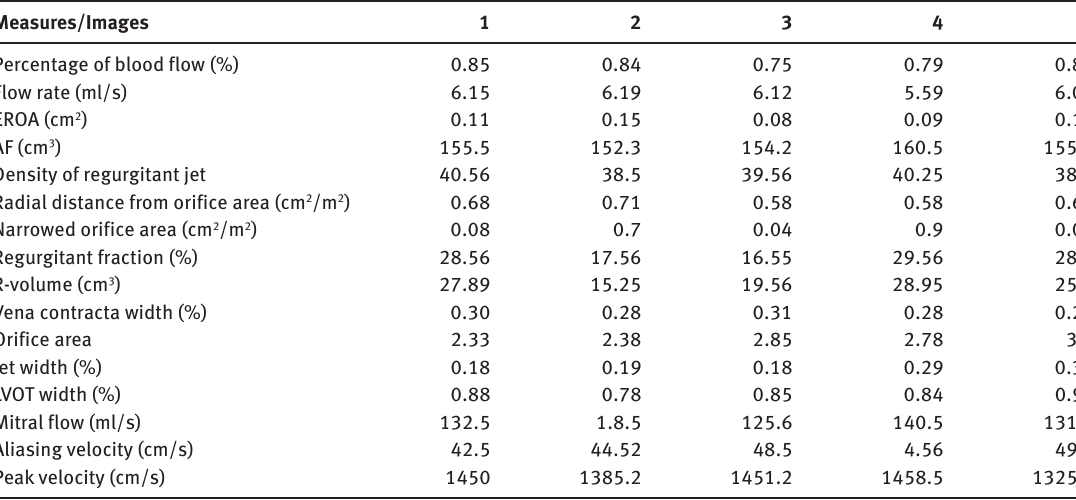
Table 3: Quantified Parameters in Segmented Jet Area in MR Part.